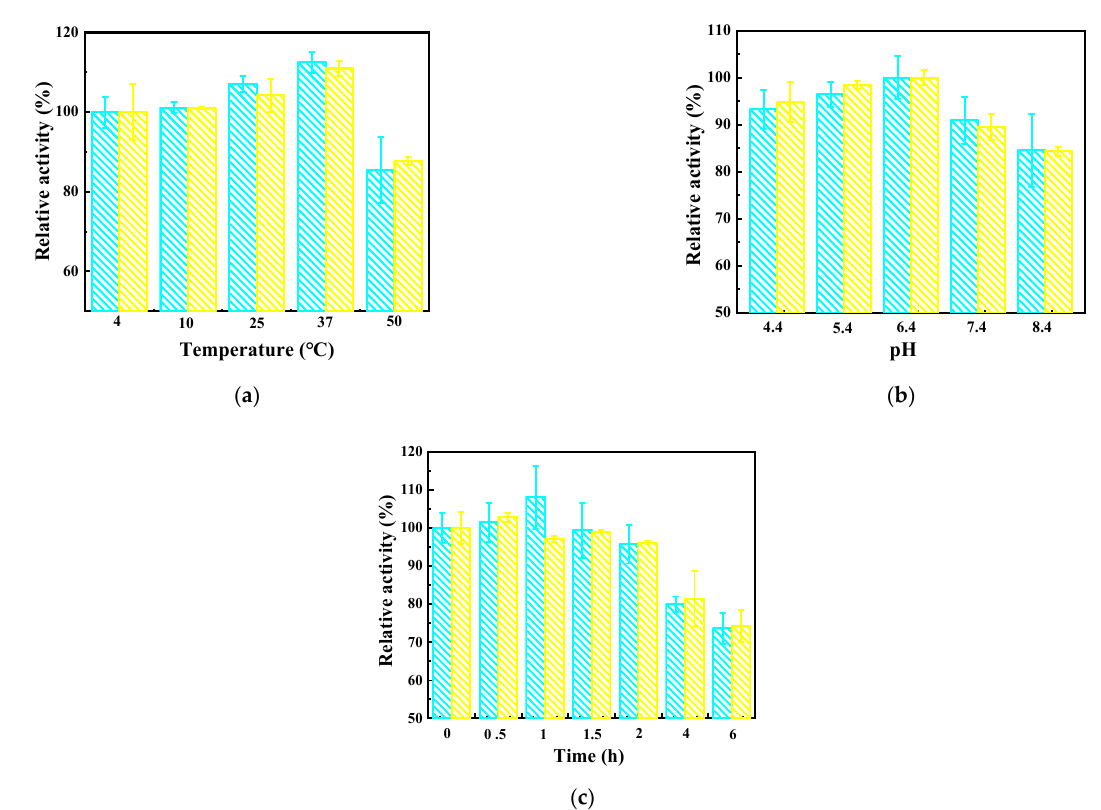
Figure 4. The effects of temperature ( a ), buffer pH ( b ), and time ( c ) on the enzyme activities of GOx/OMC-COOH (blue) and GOx-NH 2 /OMC-COOH (yellow).